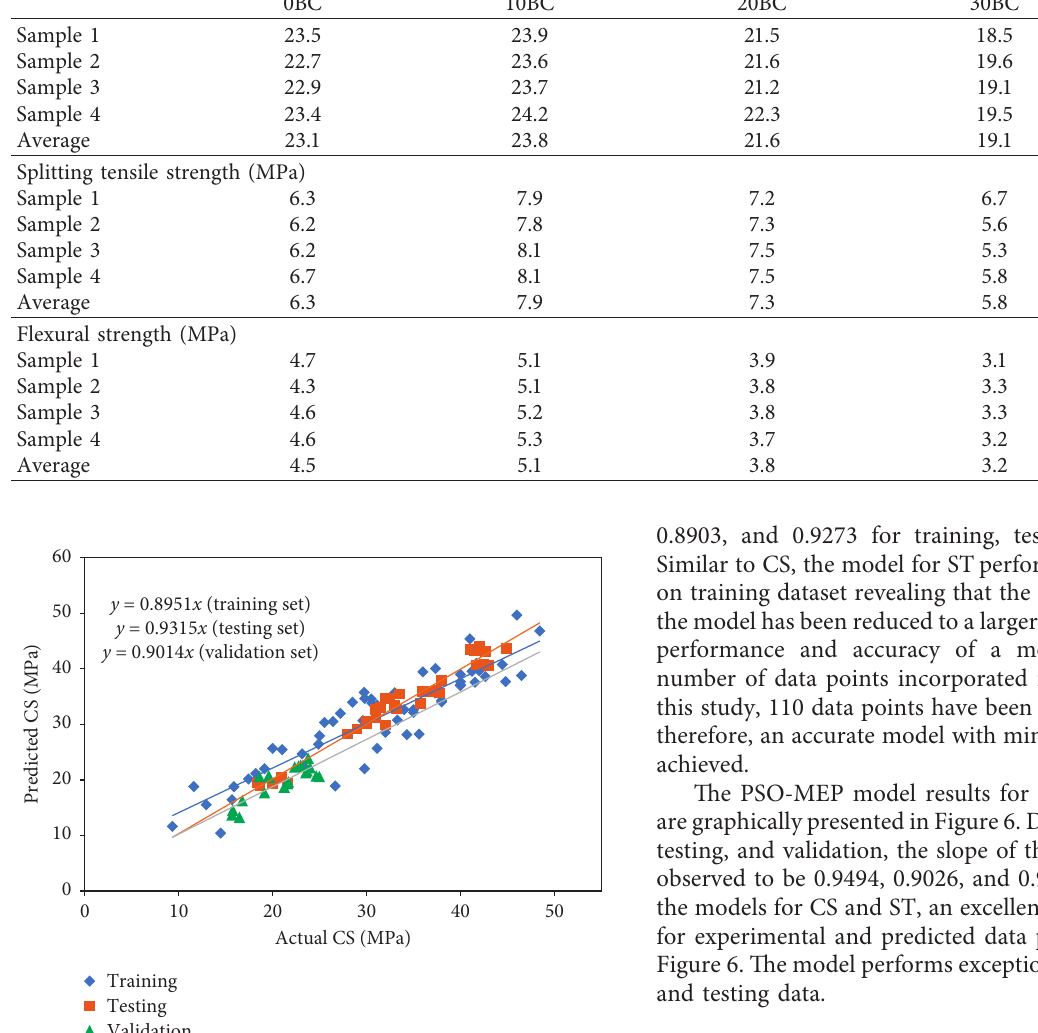
Figure 4: Comparison of actual and predicted